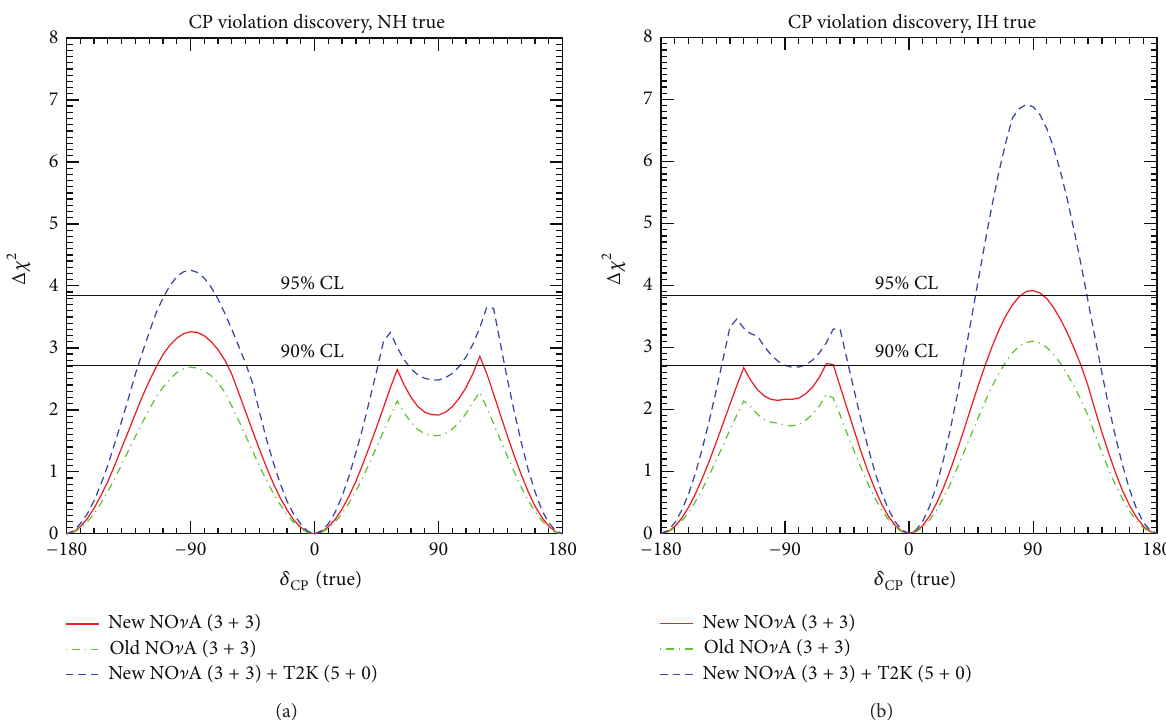
Figure 7: Left panel (right panel) shows the Δ𝜒 2 for the CP violation discovery as a function of true value of 𝛿 hierarchy. This figure has been taken from